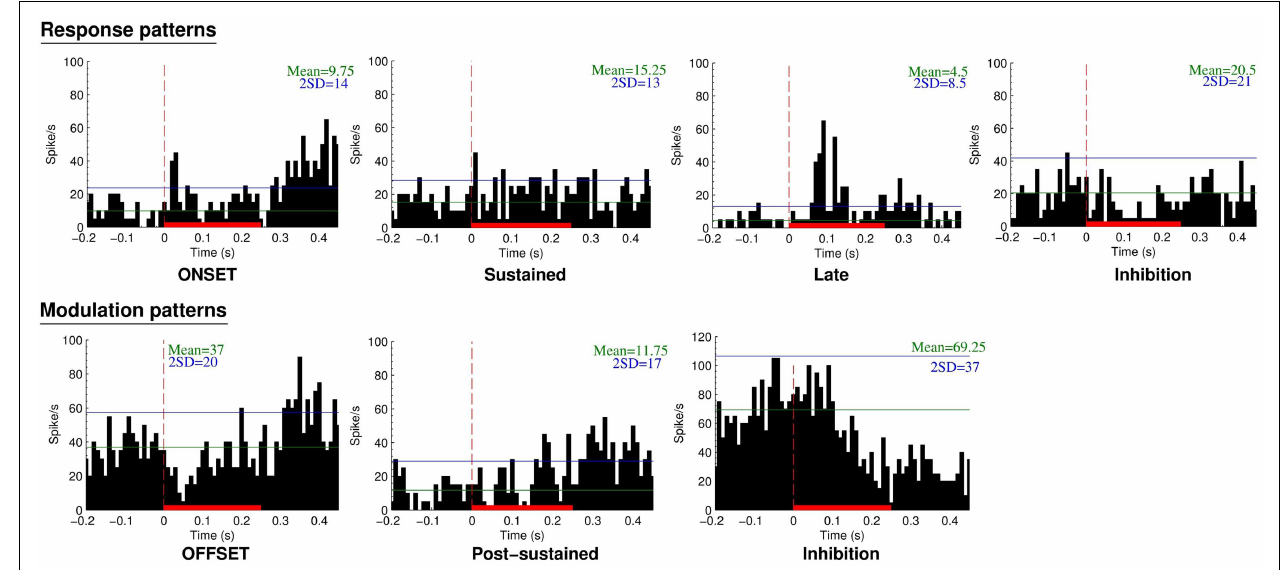
The vertical red line at time zero is the onset of stimulus presentation. Bin width is 10ms.The horizontal green line represents the mean discharge rate of reference derived from the period preceding the presentation of the stimulus.The blue horizontal line is the mean discharge rate of reference plus 2 SDs, considered as the limit of confidence for an excitatory response.